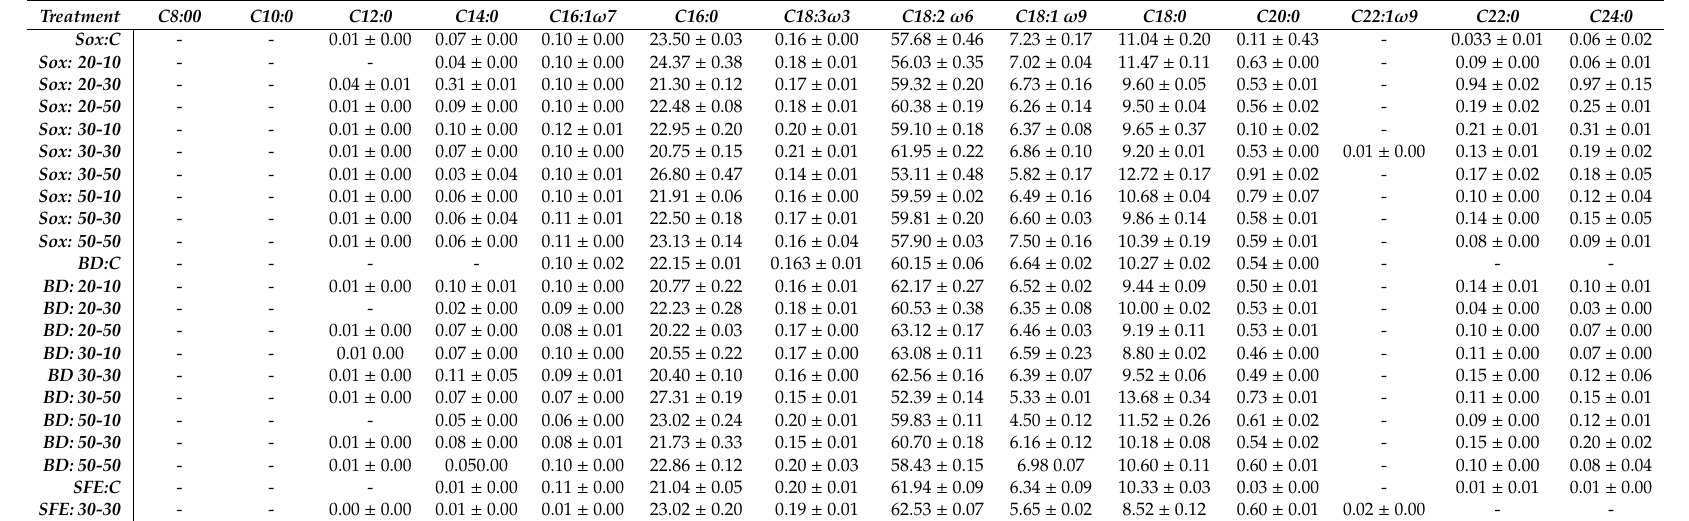
Table 1. Comparison of fatty acid profile (% area) of grape seed oil samples using di ff erent treatment conditions (ultrasound) by low pressure methods (Sox and BD), the best extraction condition for supercritical fluid (SFE) and their respective untreated controls (C).